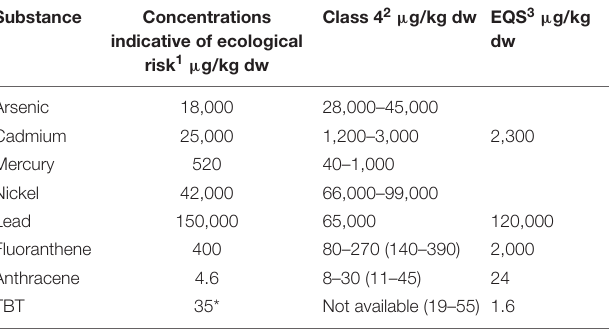
TABLE 6 | A comparison between concentrations used in Norwegian guidelines for sediment risk assessment indicating when ecological risk cannot be excluded; and concentrations in sediment corresponding to highly contaminated Swedish background levels from 1999 (updated values from 2014 in parentheses); and EQS for chemical status as per the